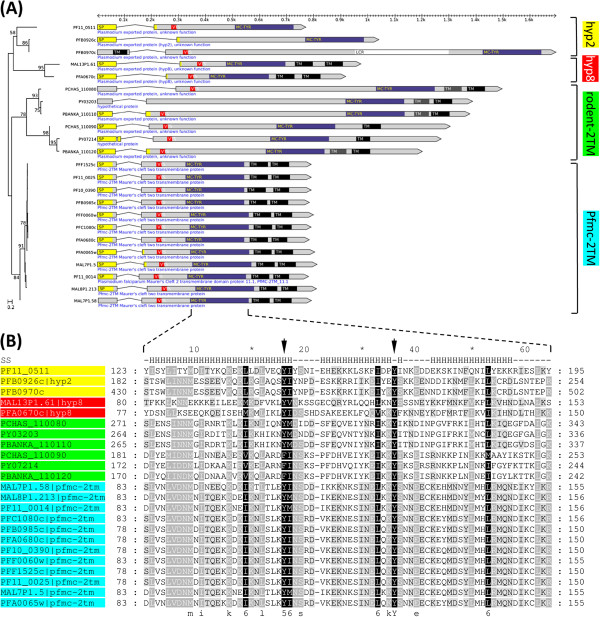
PfMC-2TM is conserved in rodent malaria parasites and related to P. falciparum HYP2 and HYP8 proteins through the novel MC-TYR domain. (A) Members of the P. falciparum gene families Pfmc-2TM, hyp8 and hyp2 as well as six rodent parasite genes share a conserved ~70 aa domain named MC-TYR (dark blue) located between the PEXEL/VTS motif (shown in red) and the two C-terminal transmembrane domains (TM, shown in black). TM domains in dark gray are predicted by Phobius but not TMHMM. SignalP predicted signal peptides (SP) shown in yellow. The phylogenetic tree to the left is a bootstrap consensus tree based on the MC-TYR alignment shown in panel B. Numbers represent bootstrap values (values below 60 not shown). (B) T-coffee multiple sequence alignment of MC-TYR. The name stands for Maurer’s clefts tyrosine domain due to two almost invariably conserved tyrosine residues (Y, indicated by arrows), which are of potential functional importance. Top row: ‘H’ denotes residues within predicted alpha helices, thus MC-TYR has a predicted three alpha-helical secondary structure (SS).